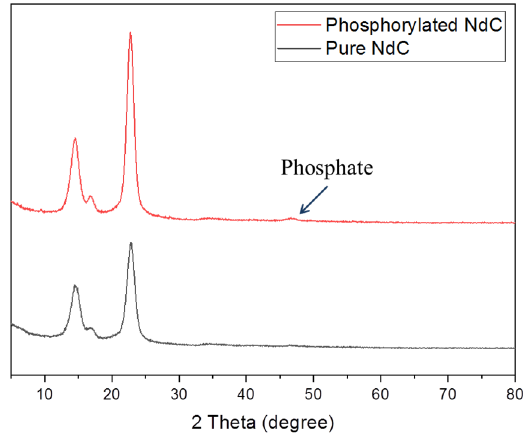
Figure 3. XRD spectra of pure NdC and phosphorylated NdC (20